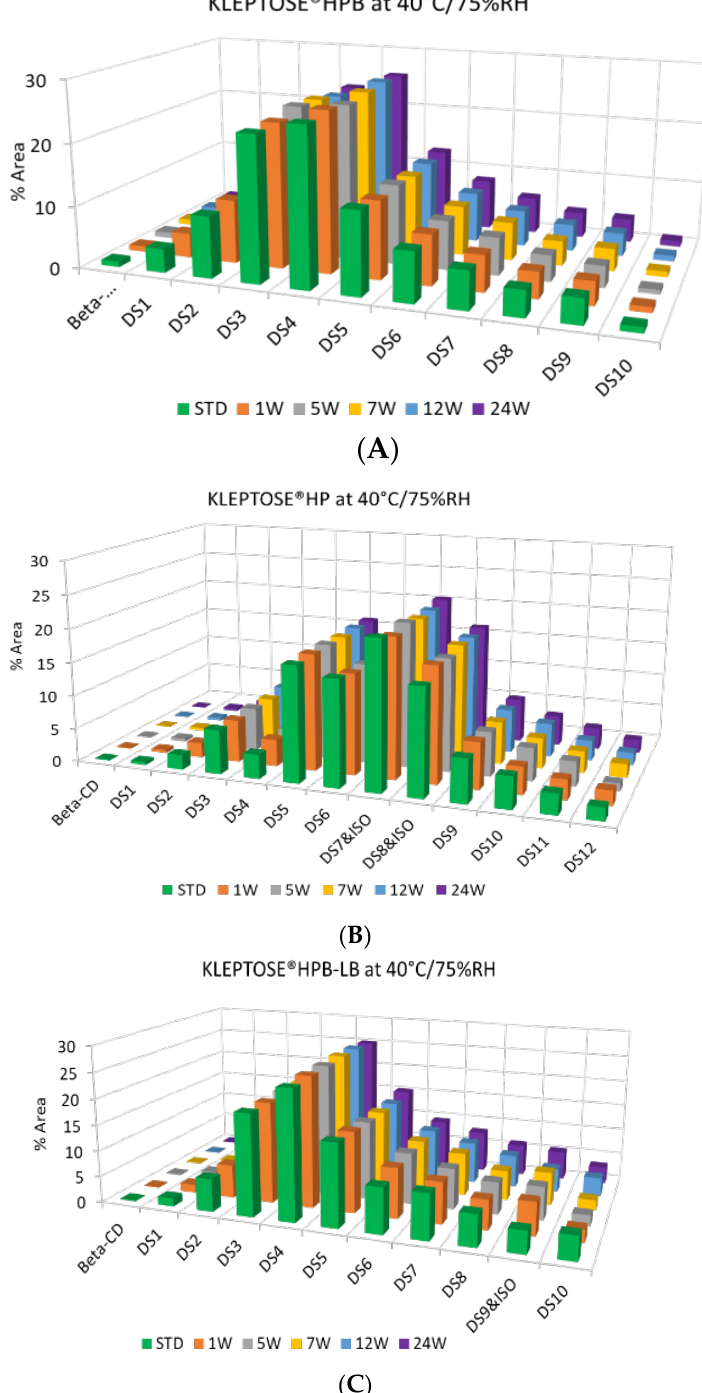
Figure 5. Molecular profiling of representative KLEPTOSE ® HPB ( A ), KLEPTOSE ® HP ( B ), and KLEPTOSE ® HPB-LB ( C ) under mild thermal stress (40 °C / 75% RH) for up to 24 weeks.